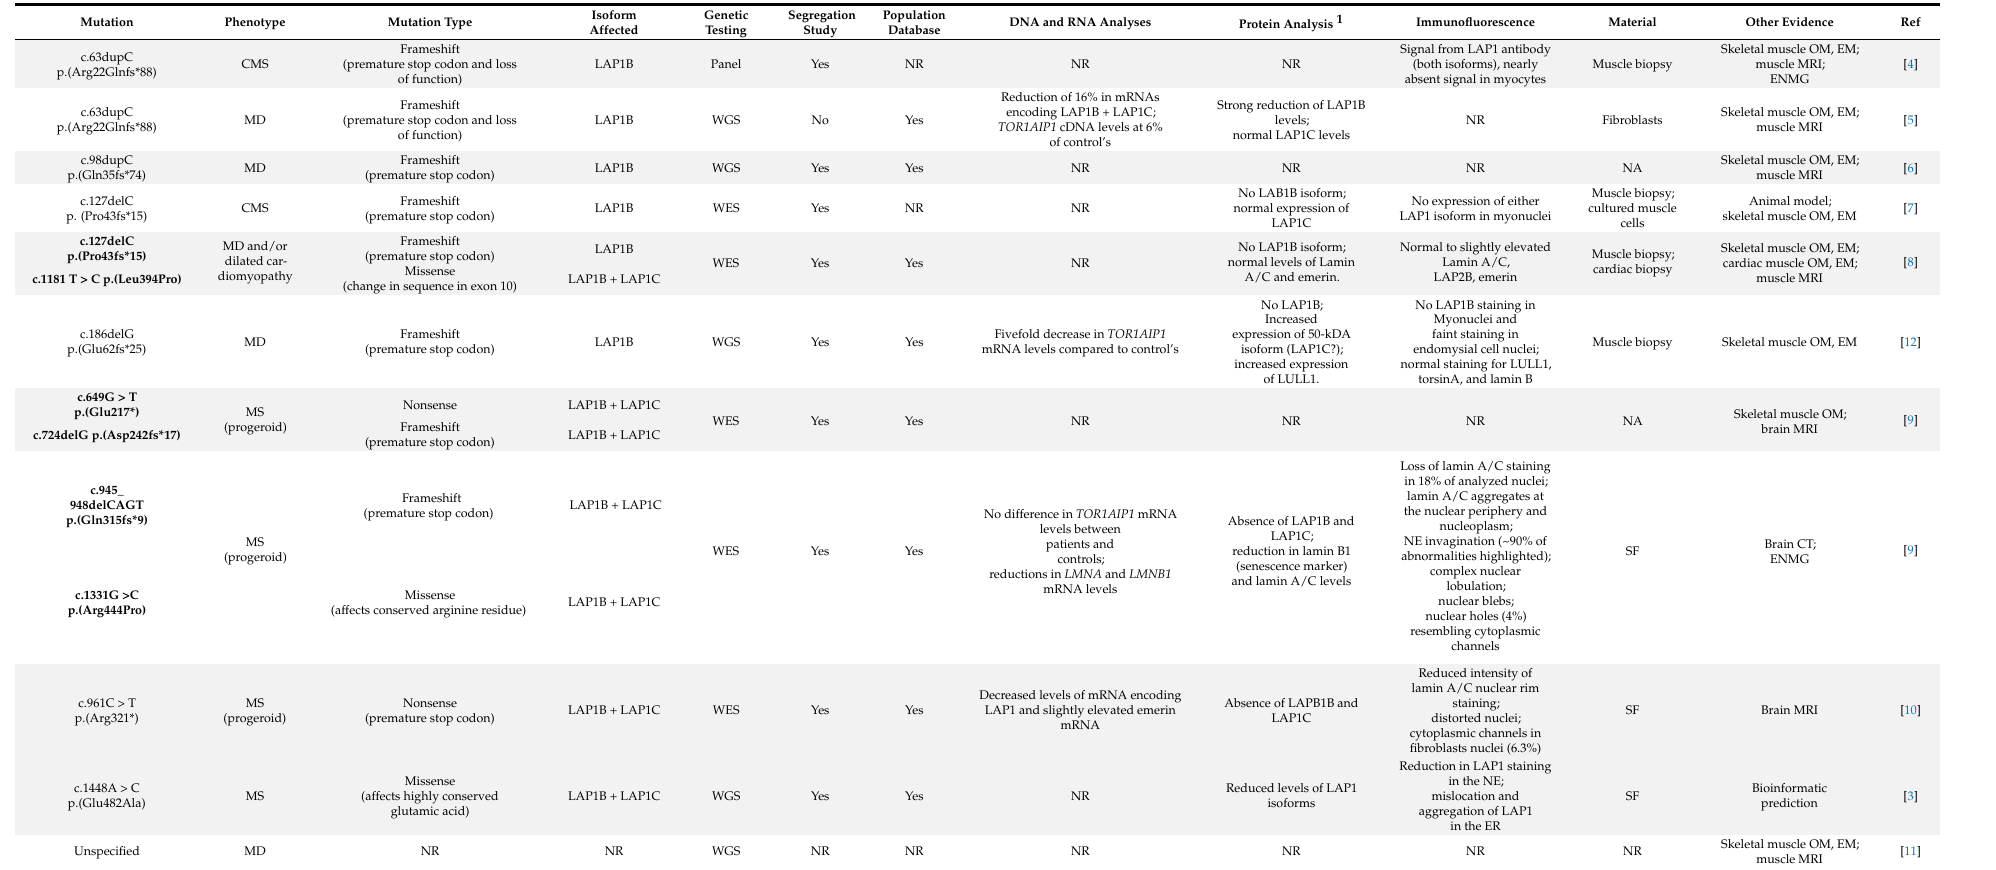
Table 1. Summary of TOR1AIP1 mutations and level of